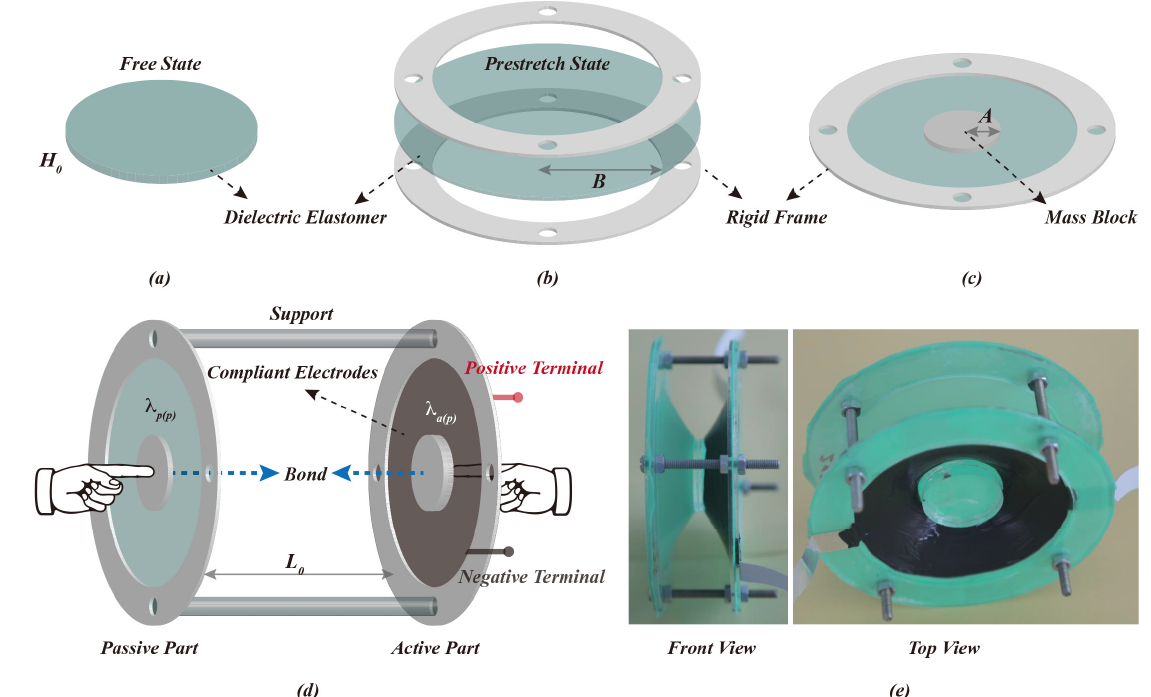
Figure 1. Push-pull DEA preparation process and experimental photos: ( a )–( c ): the DE film, with an initial thickness of H 0 , is pre-stretched and fixed to a rigid frame with an inner radius of B. A mass block with a radius of A is attached to the central position on both sides of the film; ( d ): two identical actuated units are assembled via a rigid support of length L 0 . The DE film of one of the actuated units is coated with compliant electrodes, which serve as the active part, and the equal biaxial pre-stretching applied to the film is λ a ( p ) . Meanwhile, the other actuated unit serves as the passive part, and its film is subjected to equal biaxial pre-stretching of magnitude λ p ( p ) . The push-pull DEA is accomplished by bonding the mass blocks in the active and passive parts; ( e ): front and top views of the push-pull DEA in the experiment.